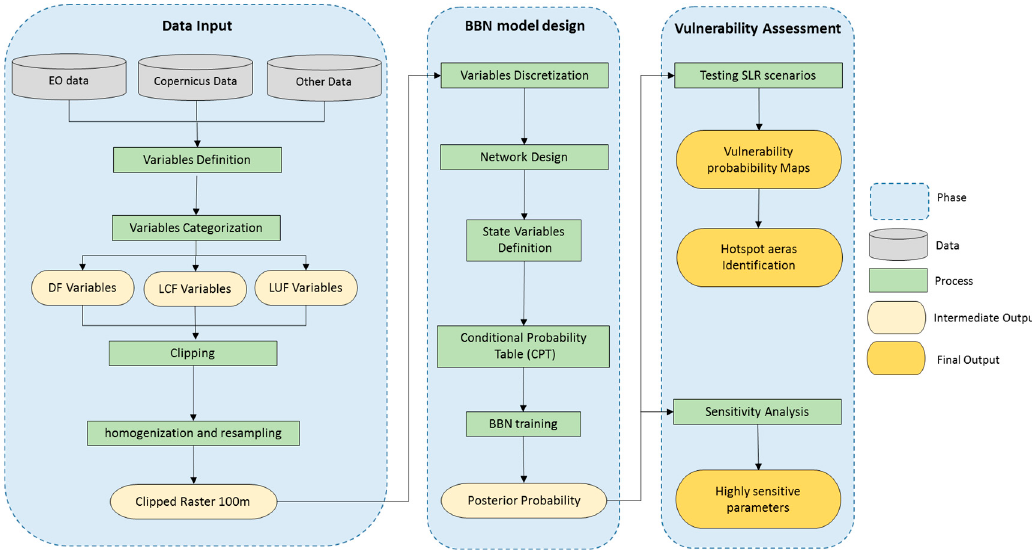
Figure 2. Flowchart of methodological phases to characterize the vulnerability conditions for each sea level rise (SLR) scenario merging different kinds of variables grouped in three broad classes representing driver factors (DFs), land cover factors (LCFs), and land use factors (LUFs) derived from multiple data source.